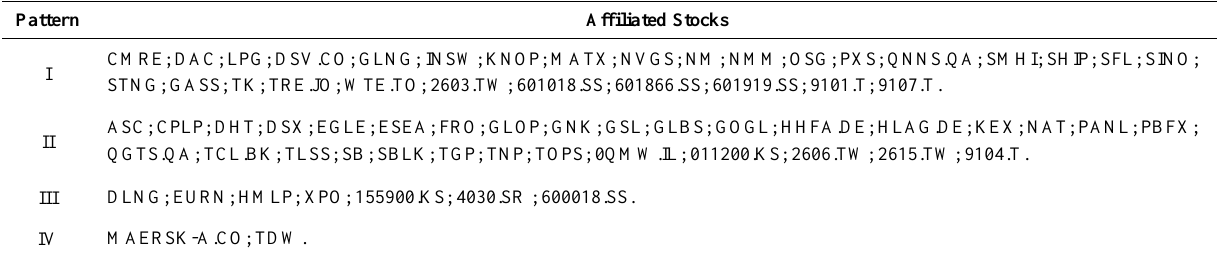
Table 6. The affiliated stocks to each Rényi entropy